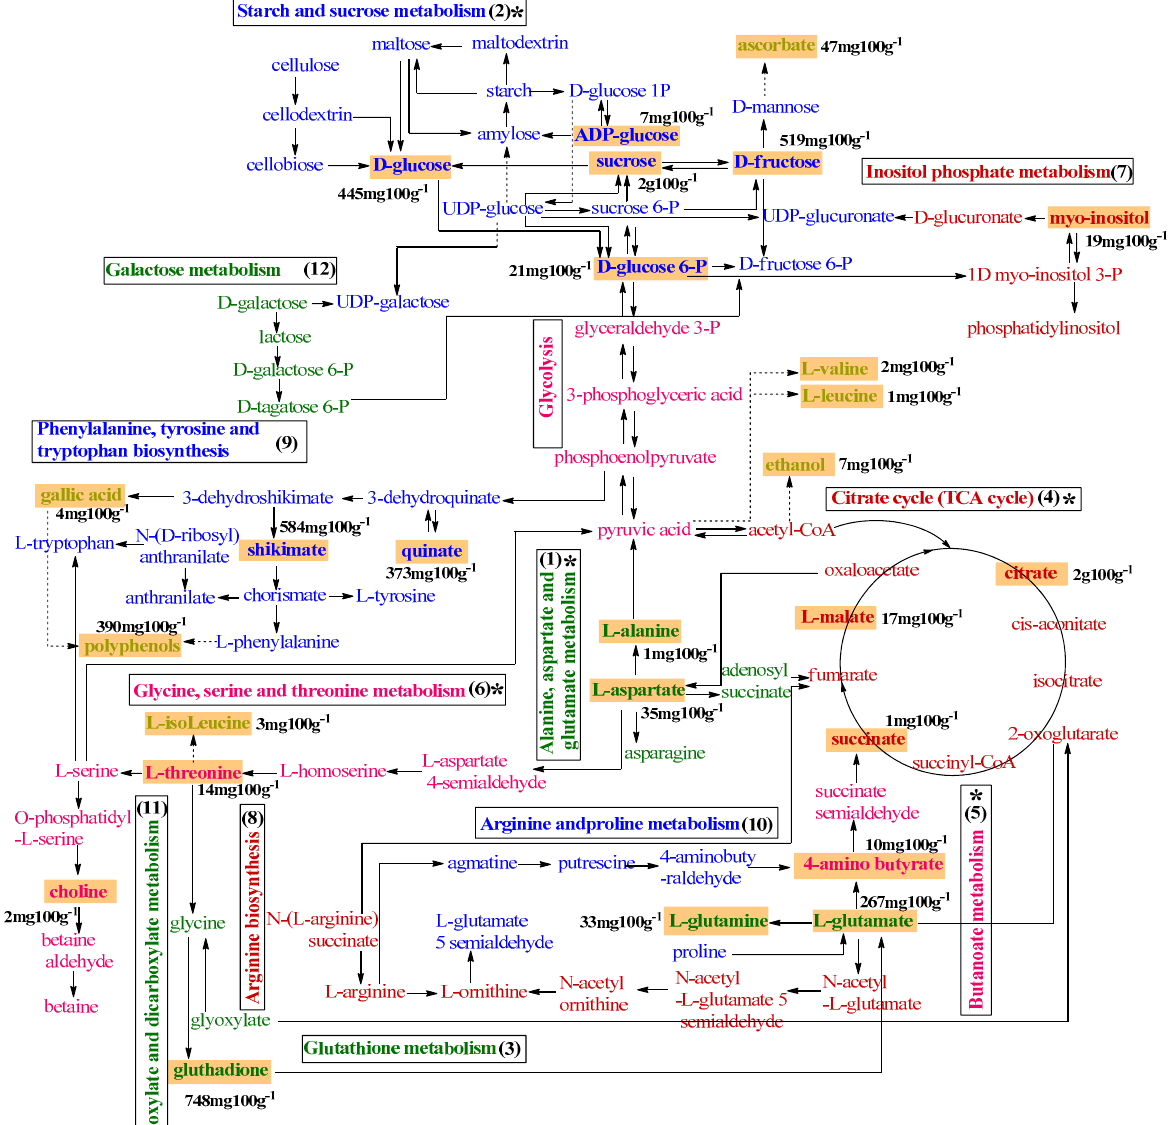
Figure 3. Pictorial representation of general metabolic cambuci pathways based on a pathway analysis. Cambuci metabolites are highlighted in an orange background with their average amounts, and their associated metabolisms are numbered by their impact factor order. The top five relevant pathways according to the –log (p) impact factors are marked with *. ADP: adenosine diphosphate, UDP: uridine diphosphate, GDP guanine diphosphate.